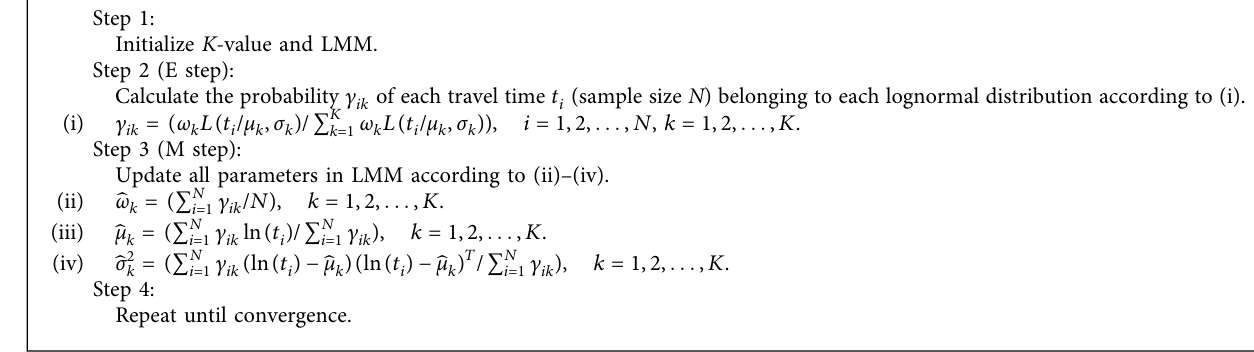
A LGORITHM 1: EM algorithm for estimating LMM.